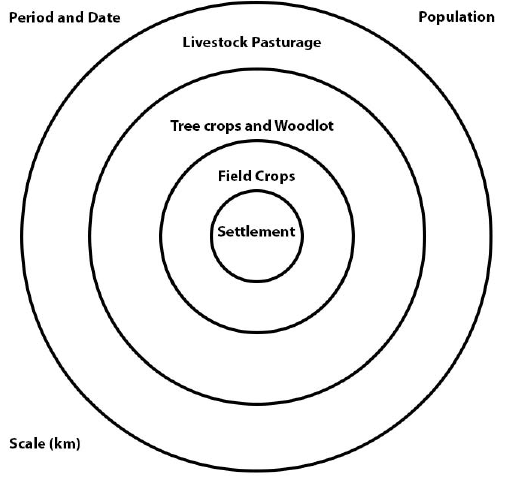
Figure 1. Schematic circle diagram showing the land use systems quantified by the